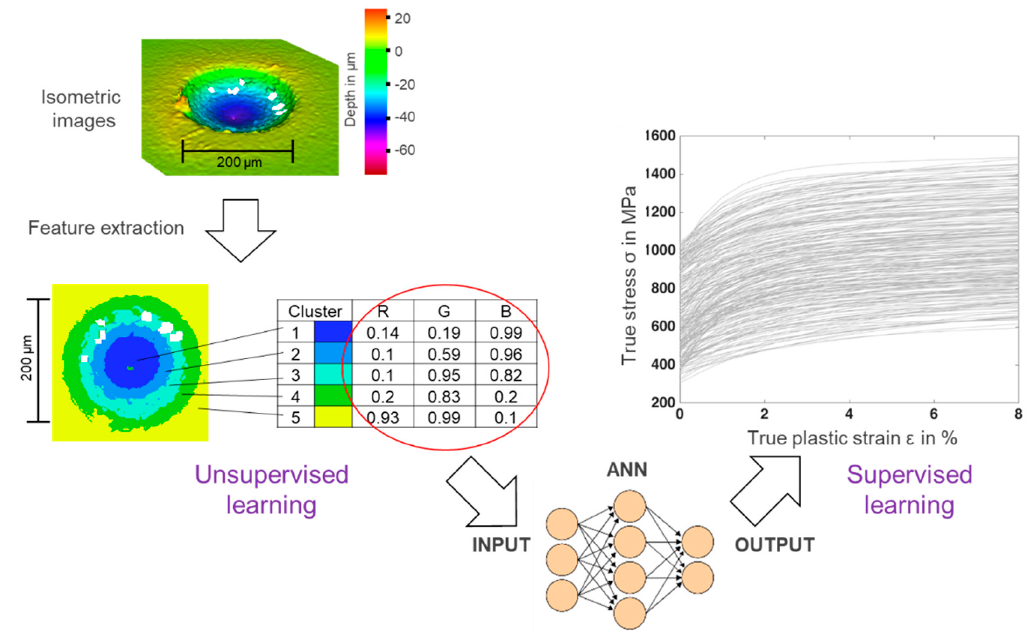
Figure 6. Feature extraction of the images from the 3D measurements and training of the ANN.